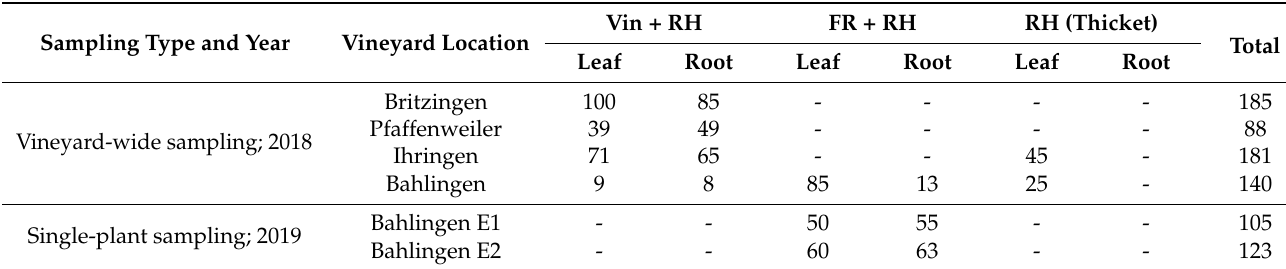
Table 1. The amount of root- and leaf-feeding phylloxera larvae sampled from rootstock hybrids (RH), V. vinifera (Vin), and fungus-resistant varieties (FR), in different grafted commercial vineyards and surrounding thickets throughout the wine-producing region Baden, South-West